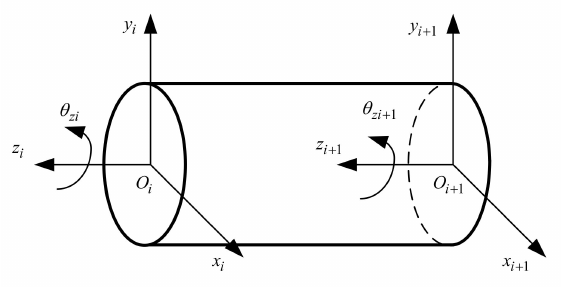
Figure 18. Axial segment